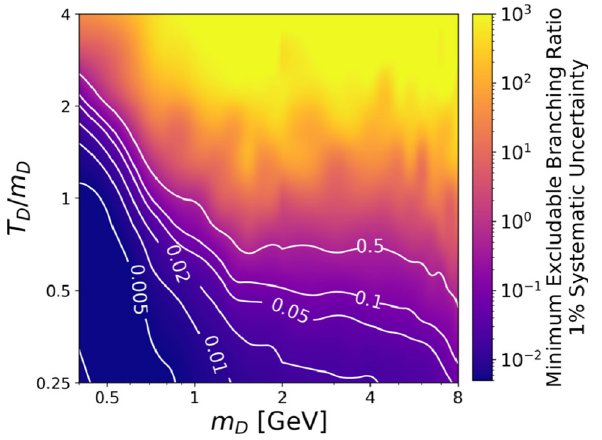
Fig. 54 MinimumexcludableBr ( h → SUEP ) attheHL-LHC,assum- ing 1% systematic uncertainty on QCD background for fully connected